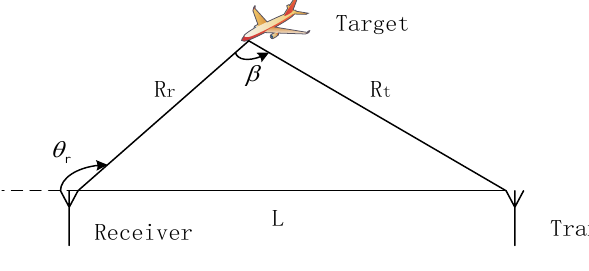
Figure 2. The geometrical relationship of PBR.